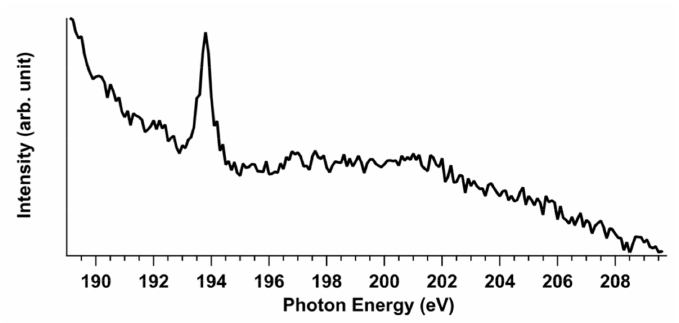
Figure 4. XAS at the B K-edge on the B-SCD sample.